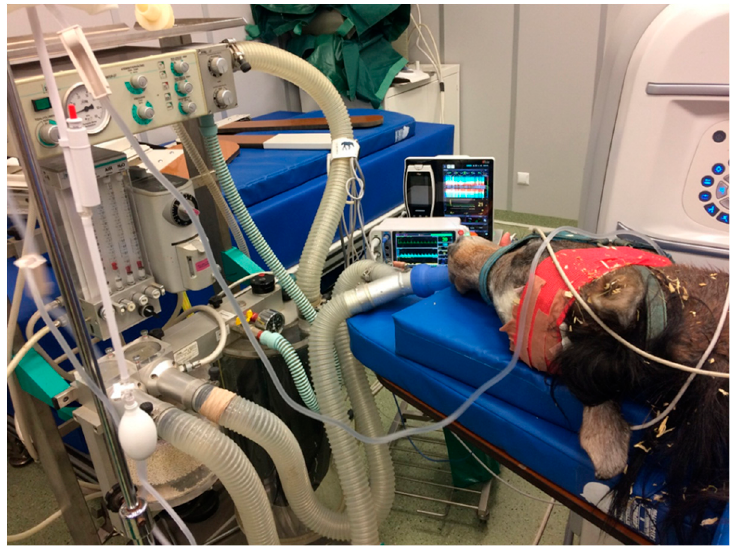
Figure 3. Parallel monitoring of vital signs and EEG analysis performer during inhalation anesthesia in computed tomography diagnostics in 11-month-old Arabian foal.